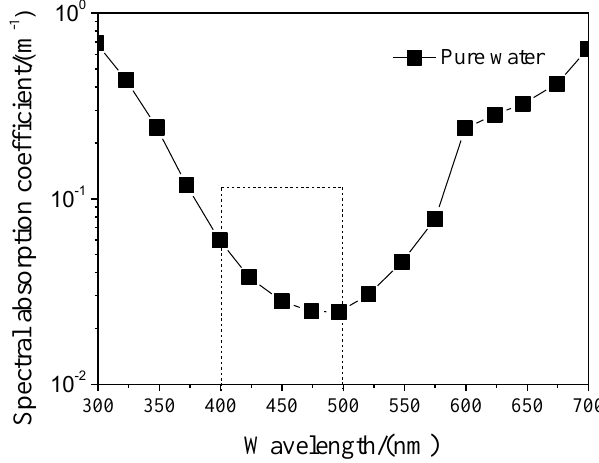
ffi cient of water